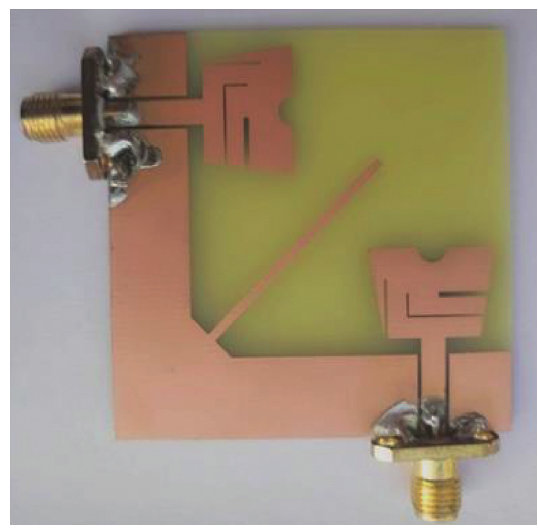
Figure 2: Photograph of the manufactured